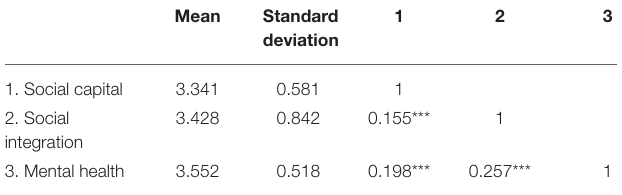
TABLE 2 | Correlation analyses among key